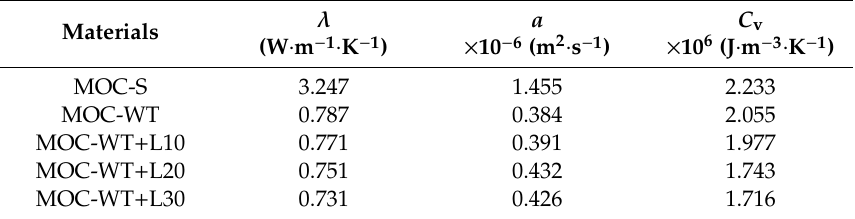
Table 7. Thermophysical properties of hardened composites.